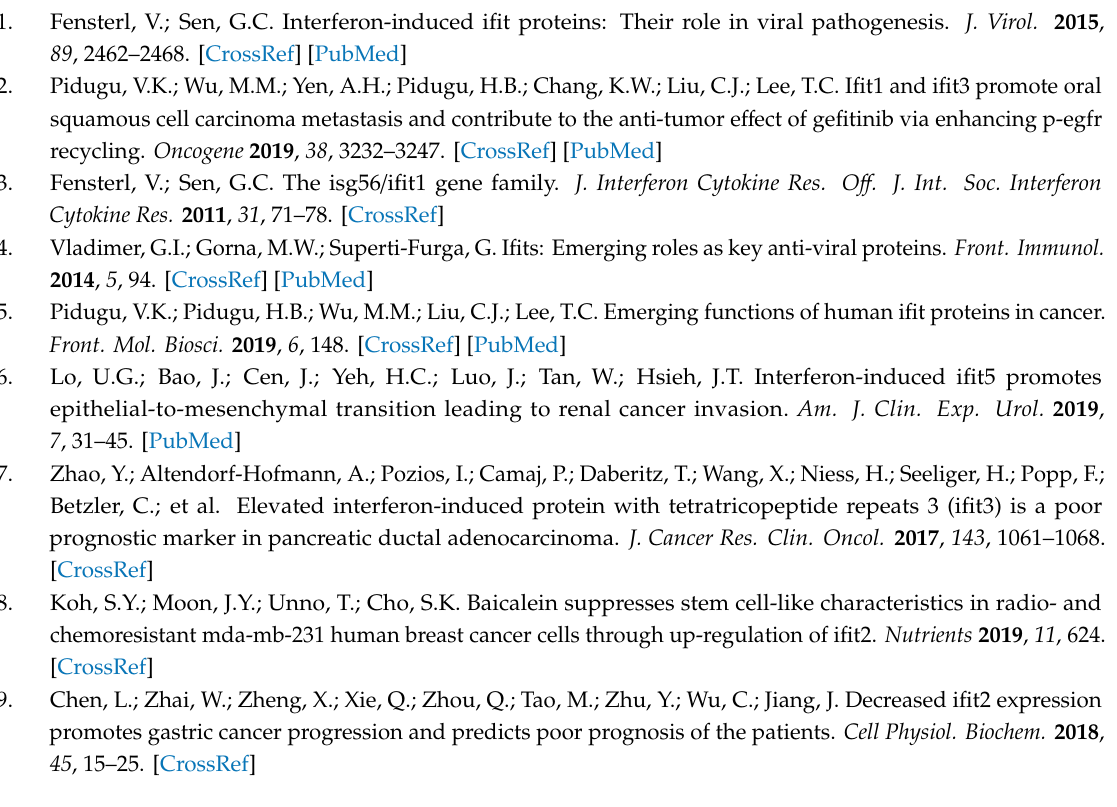
Table S1: Primer Sequences for quantitative real time PCR analysis, Figure S1: Representative images of Comet assay, Figure S2: Representative histograms of cell-cycle analysis, Figure S3: Representative image of annexin V staining for apoptosis analysis using flow cytometry, Figure S4: Original images of